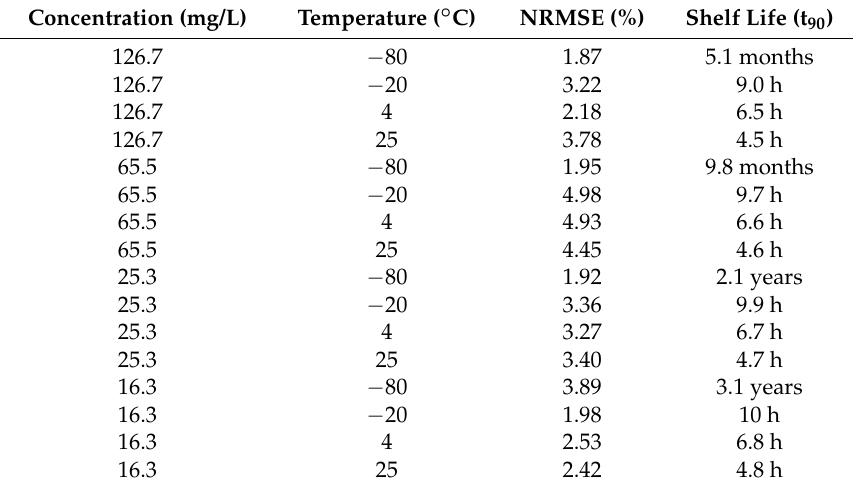
Table 3. Normalized-root-mean-square error (NRMSE) for the kinetic model of CA degradation.